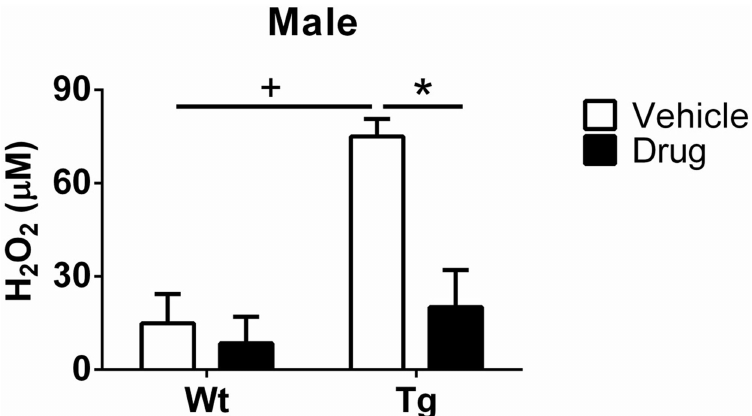
Fig 2. Determination of urine H 2 O 2 levels in male groups (treatment & genotype). A significantgenotype effect was found betweenWt-vehicle and Tg-vehiclemales, indicating a significantoxidativedamage might exist in Tg males. Moreover, there was no difference betweenWt-vehicle and Wt-drug males. However,a significantreduction was detected in Tg-drug males comparedto their Tg-vehiclecounterparts, which demonstrated that the drug might have a potentiallyprotective effect againstROS. As for female groups, H 2 O 2 concentrations were belowthe level of detection. Genotype effect (Wt v.s. Tg): +P < 0.05. Treatment effect (vehiclev.s. drug): * P < 0.05.All data are expressedas Mean ± SEM, N = 5